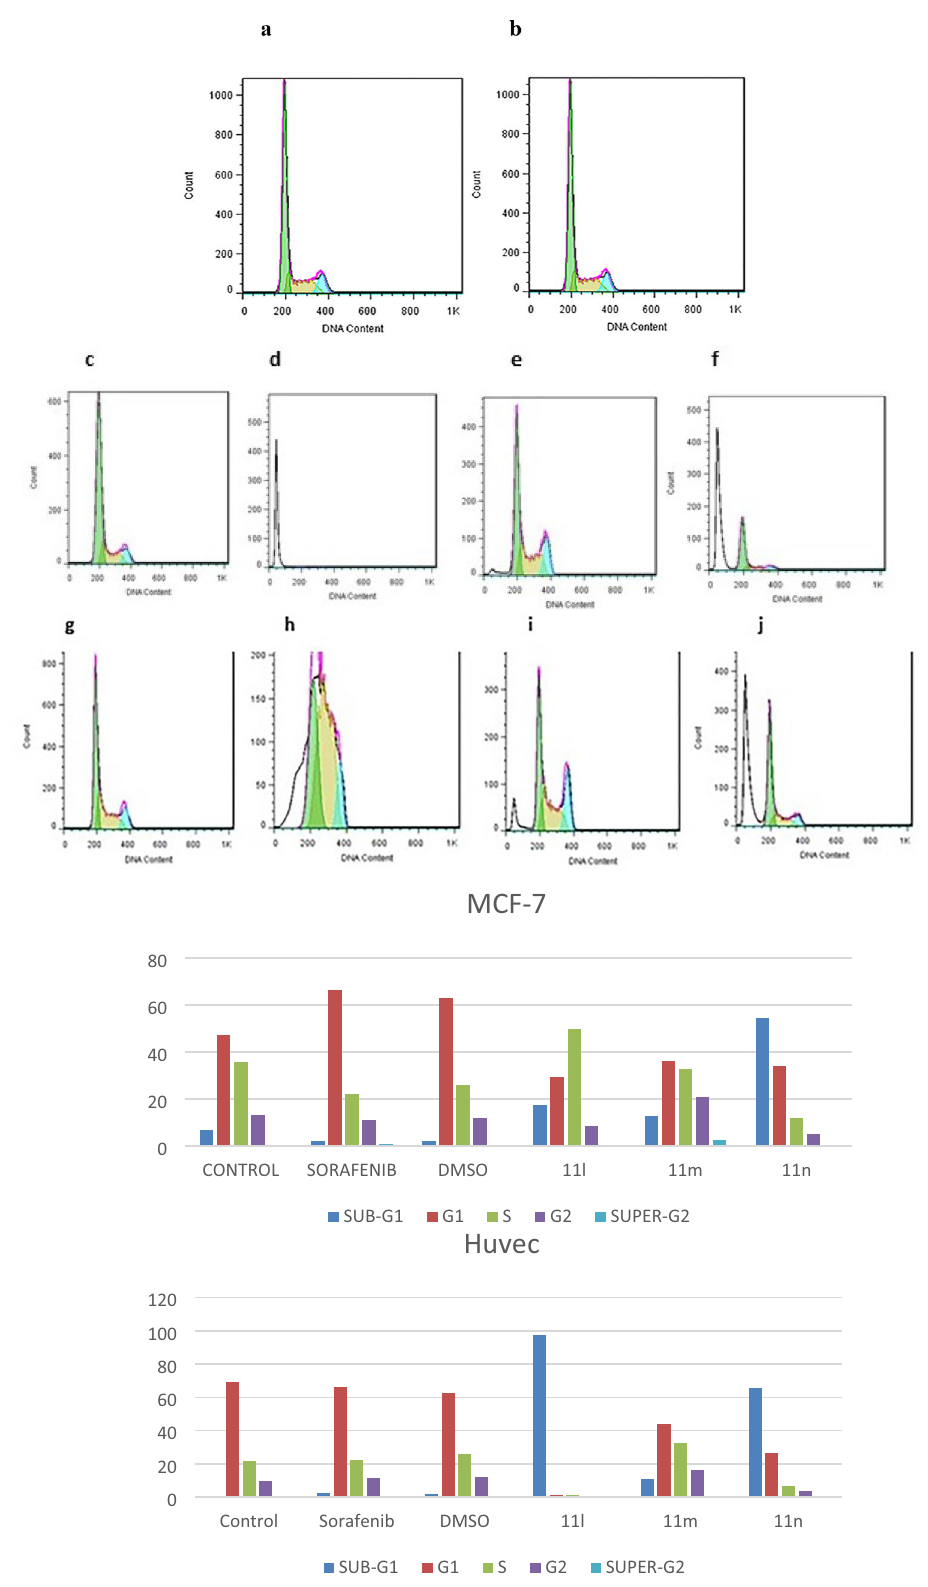
Figure 3. Flow cytometric analysis of cells cycle distribution on HUVEC and MCF-7 cells (x axis: count, y axis: DNA content) G1: Green, S: Yellow, G2: Blue, sub-G1: Without color, One time experiment was performed in one replicate; ( a , b ) treated with DMSO, sorafenib; ( c , g ) Non-treated cells as control group against HUVEC, MCF-7; ( d – f ) treated with 11l, 11m, 11n in HUVEC; (C) treated with 11l, 11m, 11n against MCF-7 at IC 50